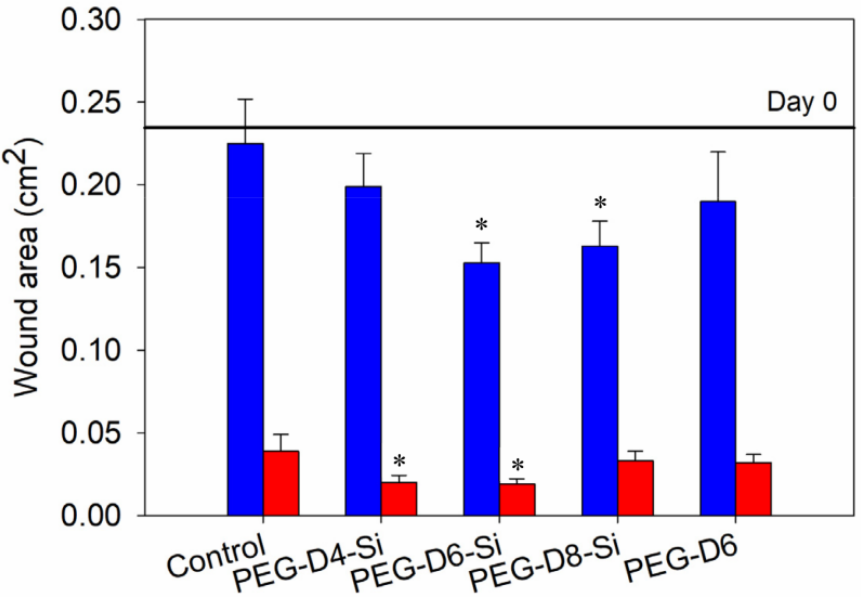
Figure 6. The wound area at days 7 ( (cid:4) ) and 14 ( (cid:4) ) post-surgery. The horizontal black line at 0.24 cm 2 represents the initial wound area at day 0. Number of repeats is 3. * p < 0.05 when compared to the control for a given time point.